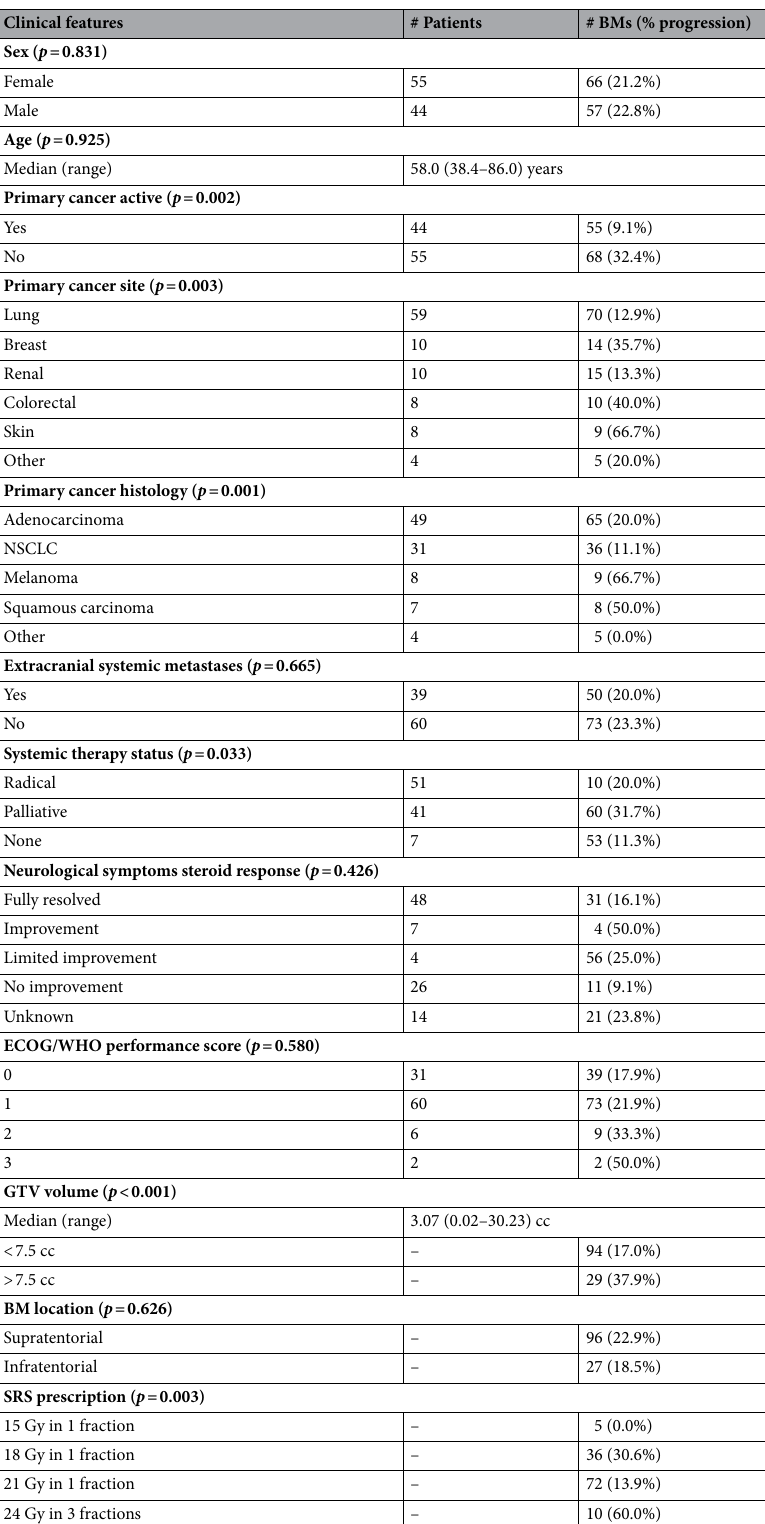
Table 1. Clinical feature distributions for number of BMs, BMs progressing post-SRS, and patients (where applicable) for the study sample. The “Neurological Symptoms Steroid Response” feature qualitatively scores the improvement of neurological symptoms after the administration of steroids, based on the previously reported methodology of Lagerwaard et al. 24 . p -values provided for statistical comparisons between BMs that progressed and did not progress post-SRS. The Wilcoxon rank sum test was used for continuous features (age and GTV volume). The Chi-squared test was used for the remaining categorical features. NSCLC non-small cell lung cancer, ECOG Eastern Cooperative Oncology Group, WHO World Health